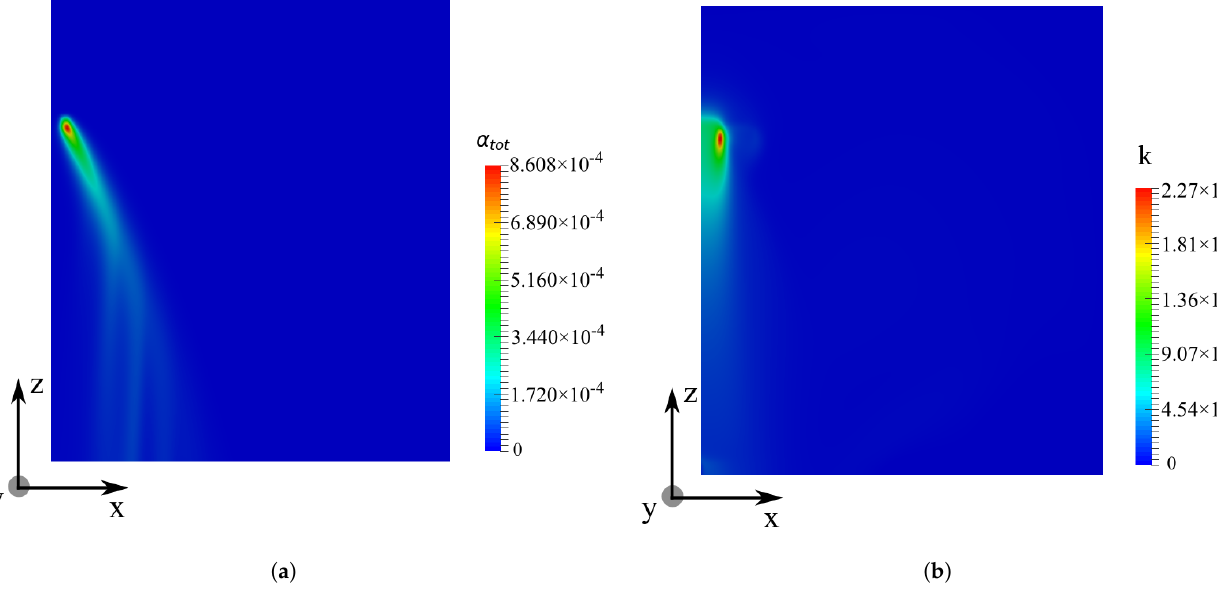
Figure 9. Spatial distribution of the properties on XZ plane at y = 0.05 m for a polydisperse spray, t = 10 s, ∆ x = 1.5 cm, ∆ t = 1 ms; ( a ) droplet volume fraction α 2 /s 2 tot and ( b ) turbulent kinetic energy k (m